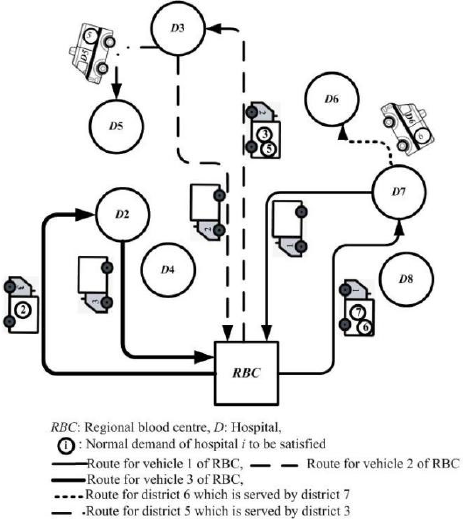
Fig. 2. The proposed decentralized distribution in a single